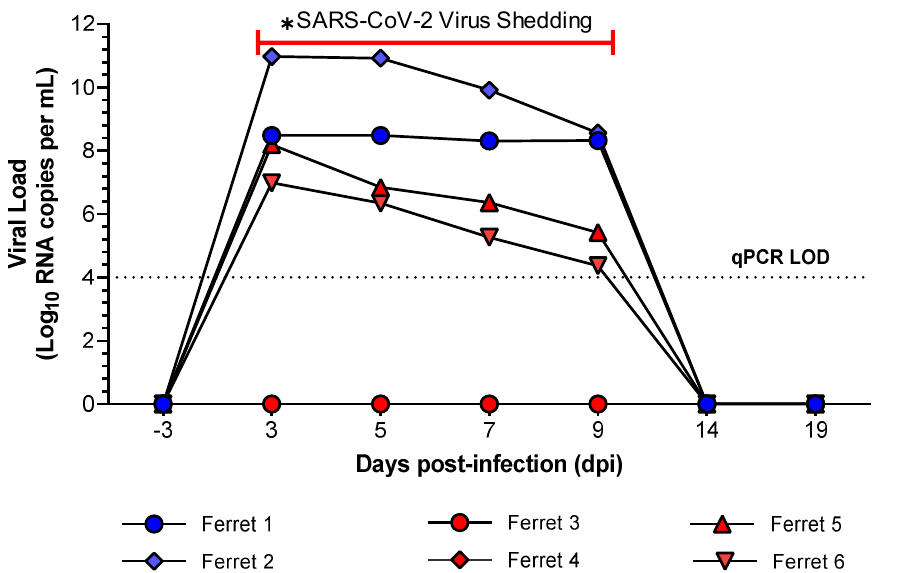
Figure 1. Determination of virus shedding in nasal washes collected from six ferrets challenged with SA01 (betaCoV/Australia/SA01/2020) and VIC01 (betaCoV/Australia/VIC01/2020) SARS-CoV-2 isolates. Ferrets 1 and 2 were challenged with 1 × 10 3 TCID 50 SARS-CoV-2 VIC01; ferrets 3 and 4 were challenged with 5 × 10 2 TCID 50 SARS-CoV-2 SA01; ferret 5 and 6 were challenged with 6 × 10 5 TCID 50 SARS-CoV-2 SA01. Nasal wash samples from SARS-CoV-2 VIC01 infected ferrets are annotated blue and SARS-CoV-2 SA01 infected ferrets are annotated red. SARS-CoV-2 RNA was detected in nasal wash samples from ferrets 1, 2, 5, and 6 on 3, 5, 7, and 9-days post-infection (dpi). The dotted line box represents the limit of detection (LOD) of the reverse transcription qPCR assay. Part of this figure contains published data found in Marsh et al. [25] .The asterisks represents the defined period for SARS-CoV-2 virus shedding used to define sample groupings.